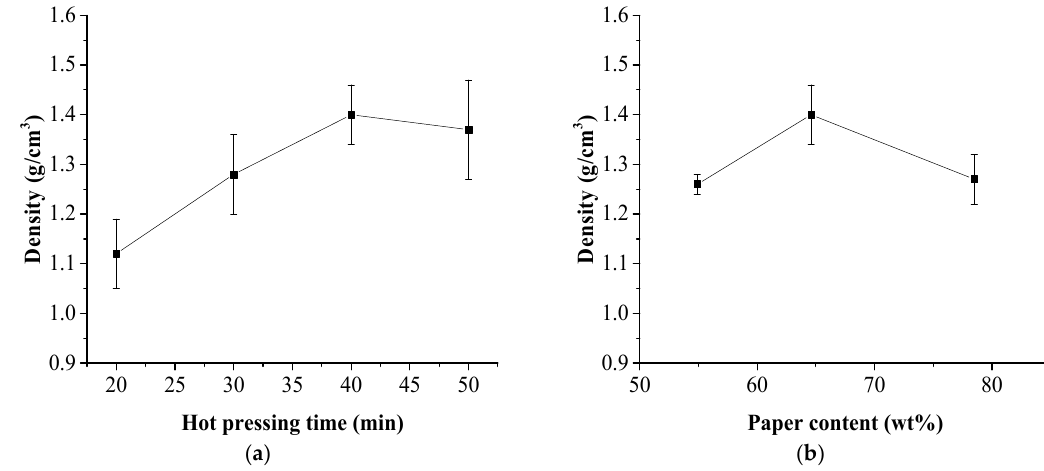
Figure 6. E ff ects of hot pressing time duration and NP content on the density of the laminated composite. ( a ) hot pressing time; ( b ) paper content.